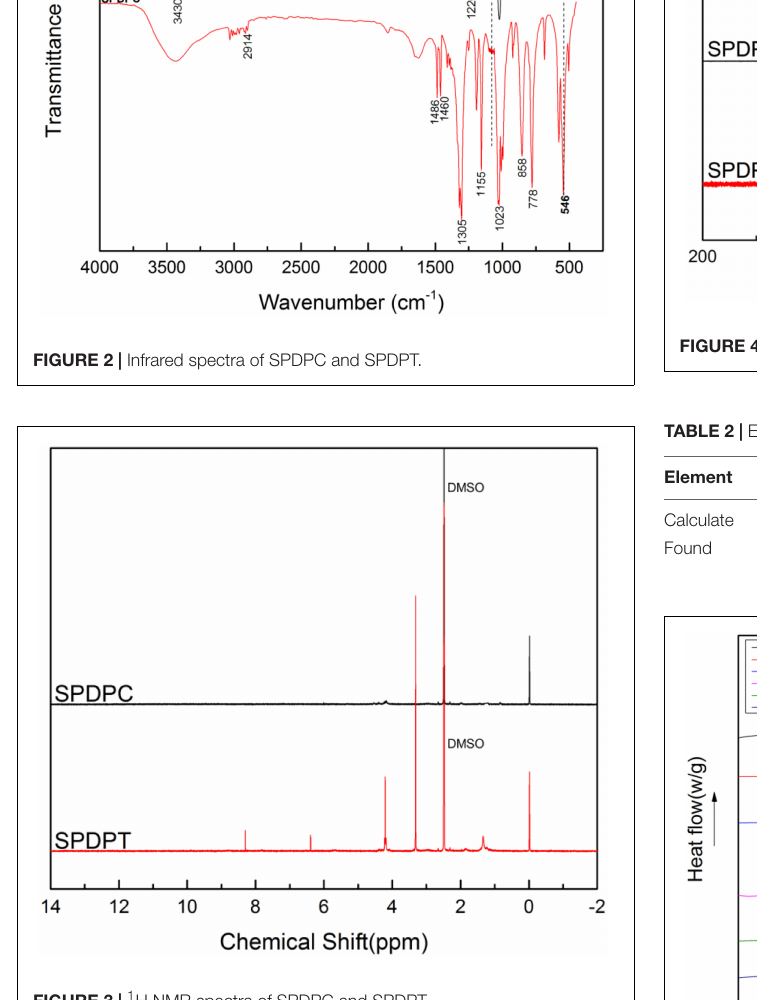
FIGURE 3 | 1 H NMR spectra of SPDPC and SPDPT.